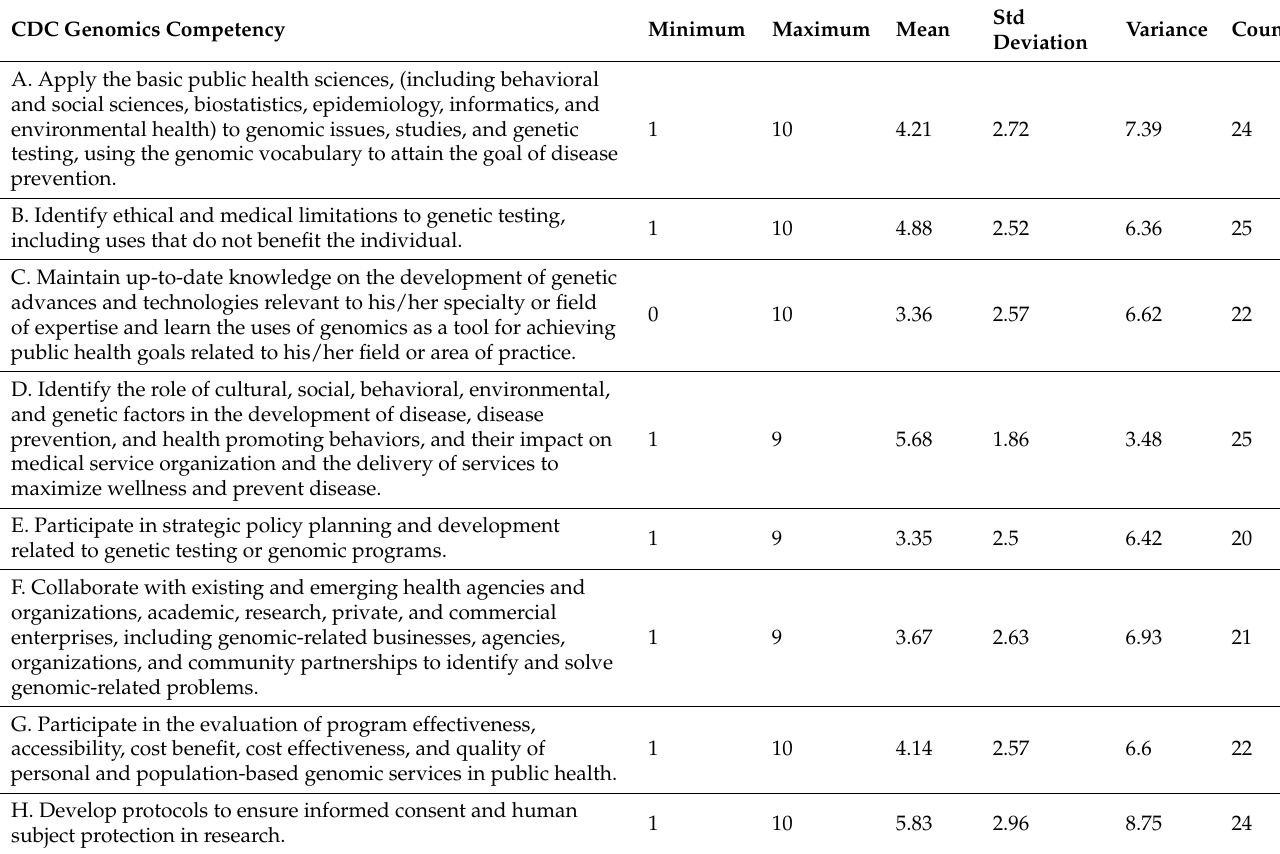
Table 2. Confidence levels of addressing CDC Genomics